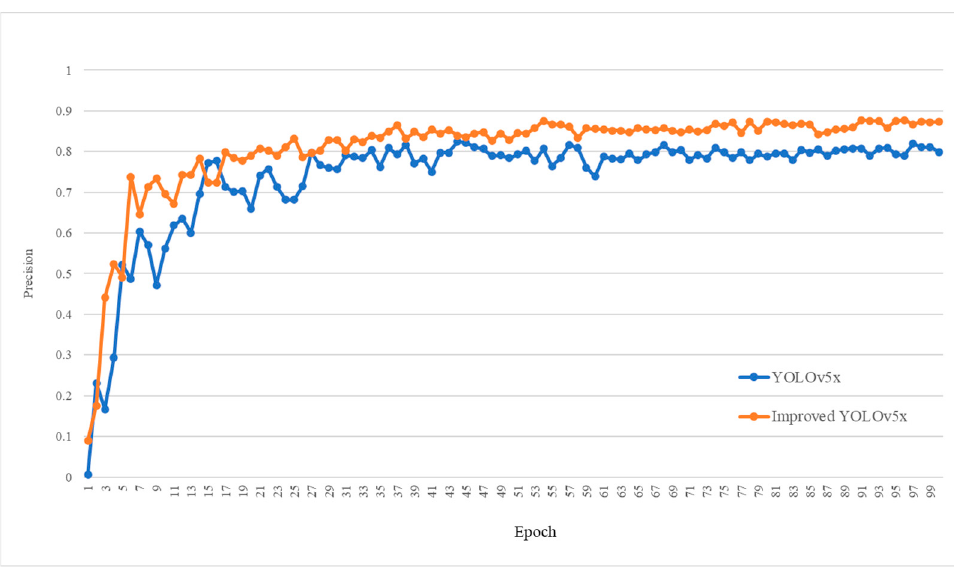
Figure 7. Variation in precision during training